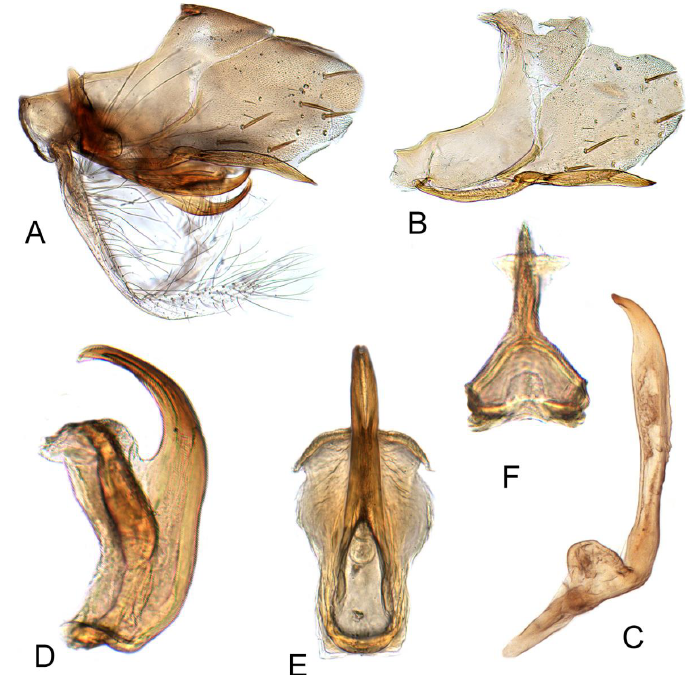
Figure 10. Batracomorphus lateprocessus Li and Wang, 2003: ( A ) genital capsule in lateral view; ( B ) pygofer side and pygophore processes; ( C ) styles; ( D ) aedeagus, lateral view; ( E ) aedeagus, ventral view; ( F ) connective.